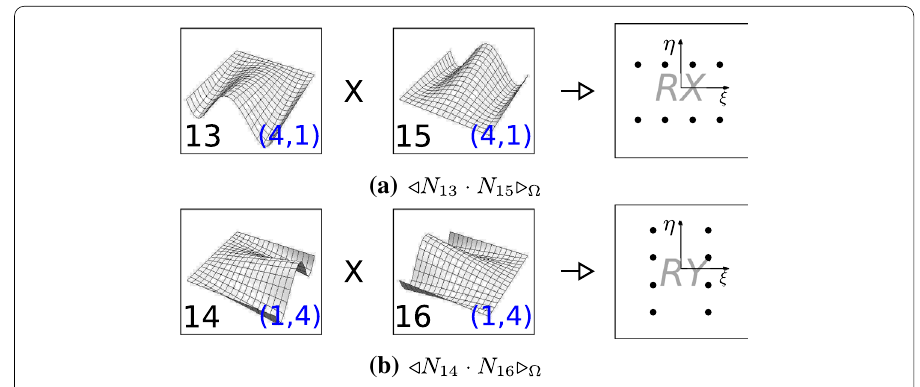
Fig. 4 Gauss points used for the reduced integration of hierarchical shell elements with p = 4. “RX” and “RY” indicate reduced integration in the ξ and η directions, respectively